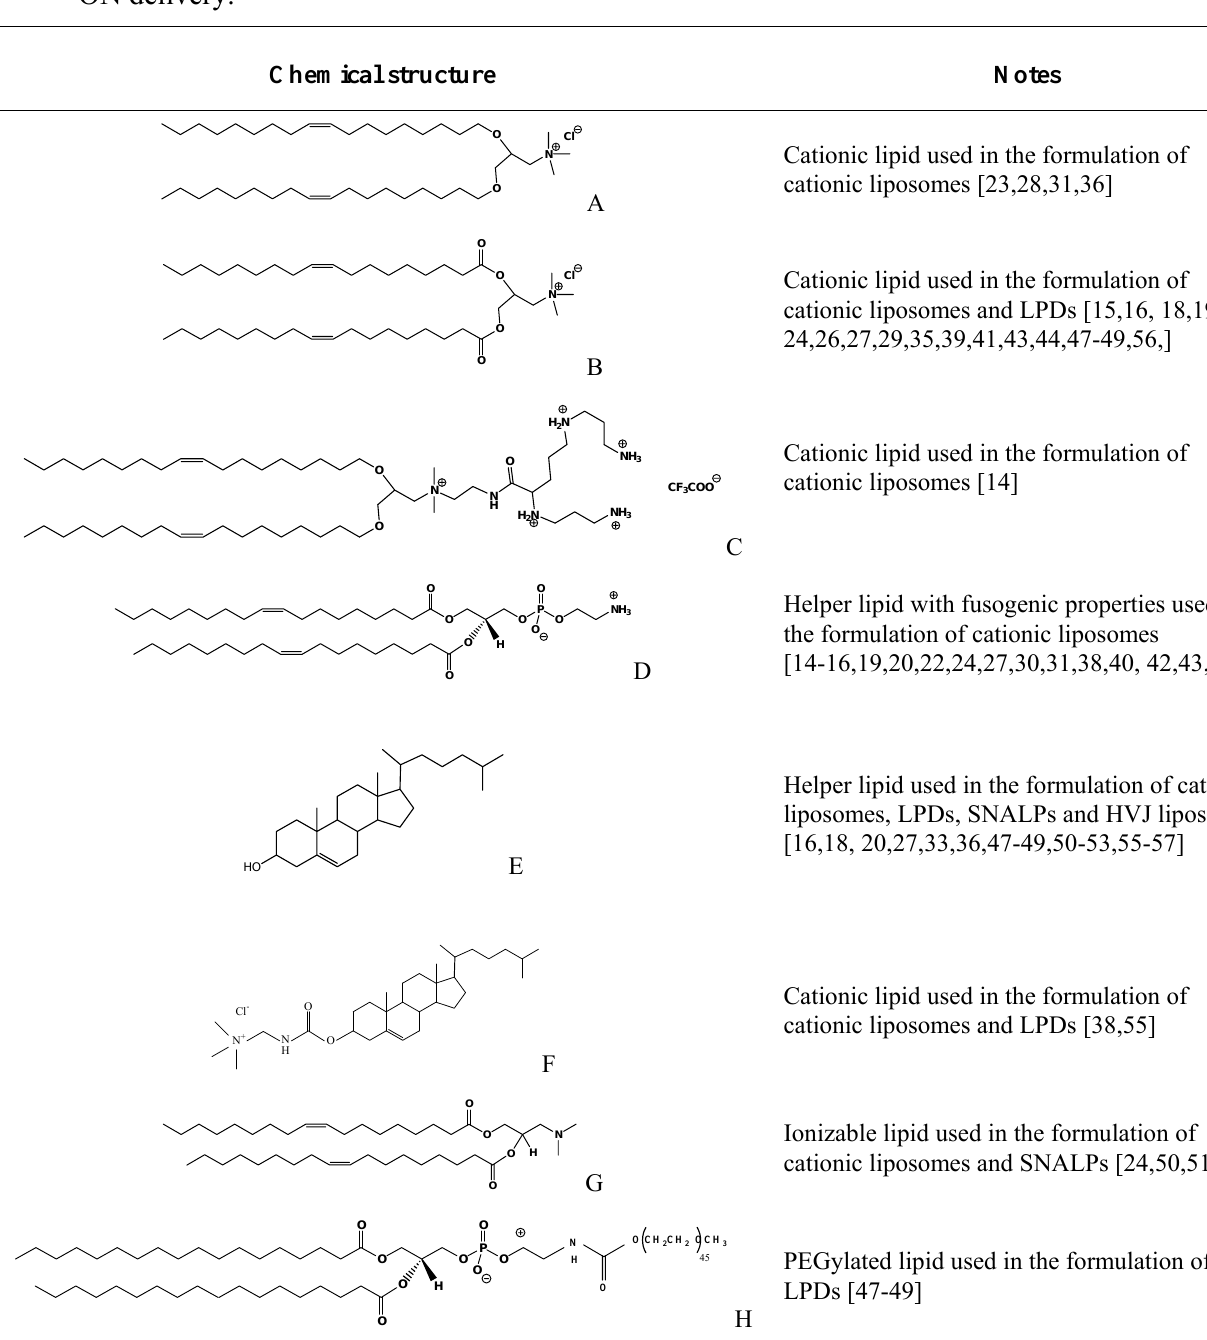
Table 1. Lipids frequently used in the formulation of lipid-based non-viral vectors for ON